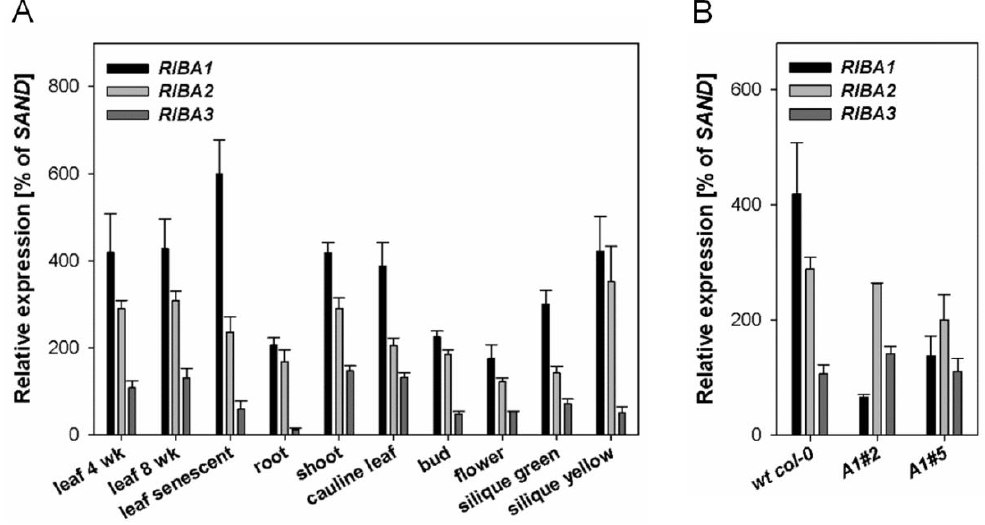
Figure 2. qPCR analyses of AtRIBA genes. ( A ) transcript accumulation of Arabidopsis RIBA genes was examined in different tissue types and ( B ), in two representative AtRibA1 antisense lines with intermediate ( A1#5 ) and strong bleaching phenotype ( A1#2 ), respectively. Expression was calculated relative to mRNA levels of SAND